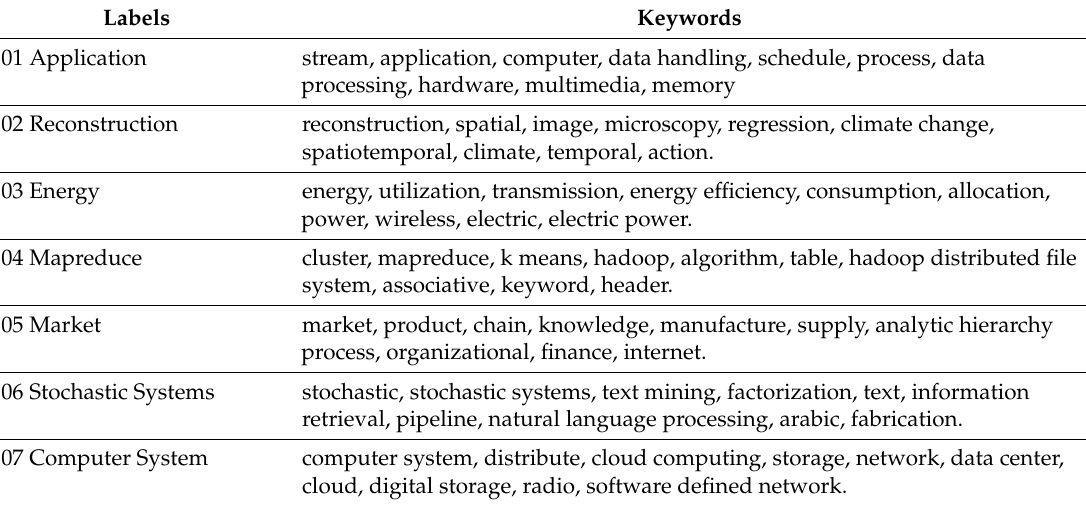
Table A3. Top 10 characteristic keywords in each cluster for the time period